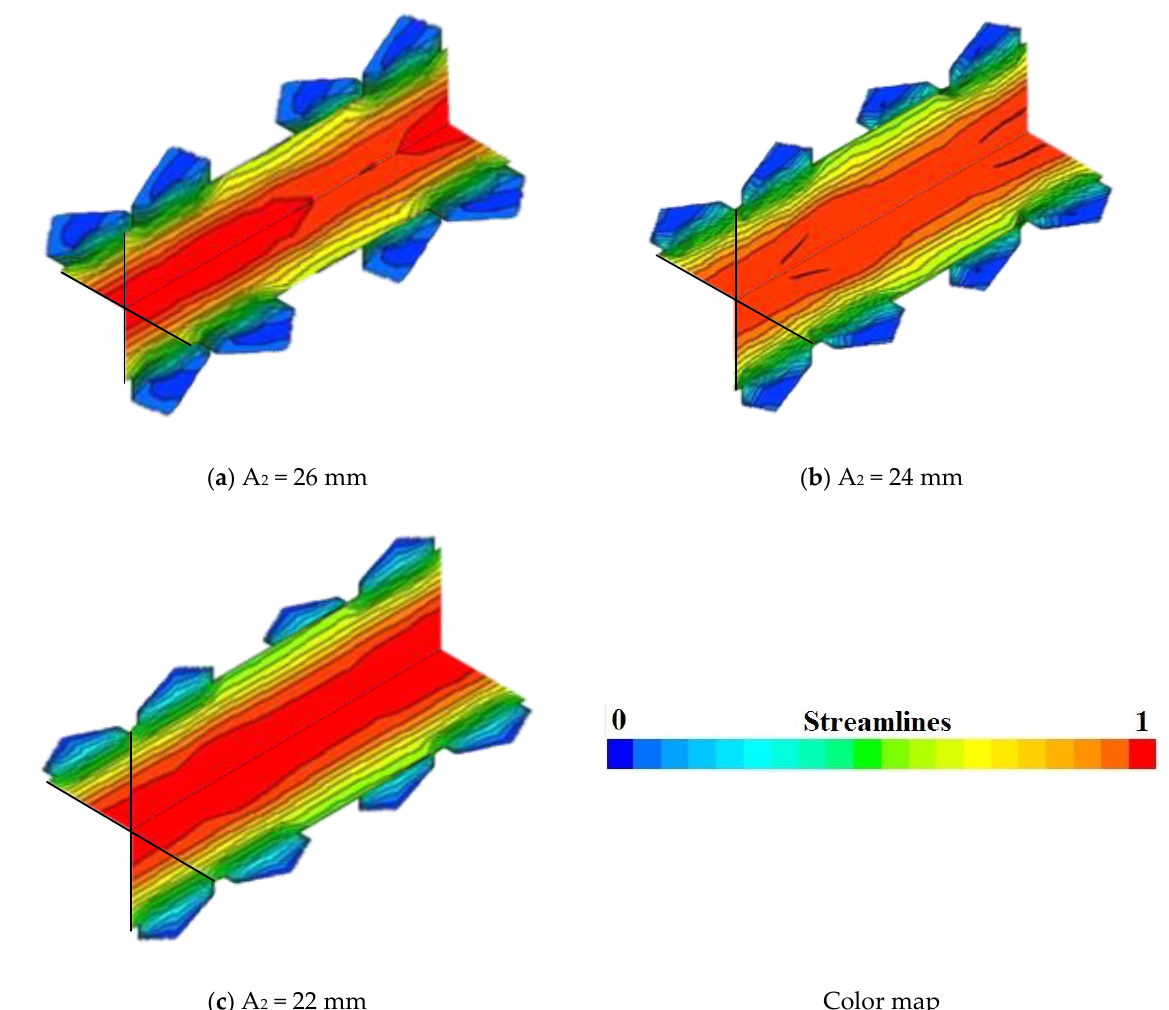
Figure 8. Streamlines for various configurations of Case A with different A 2 parameters at R = 15 mm, Re = 15,000, and 𝜑 = 0.5%.